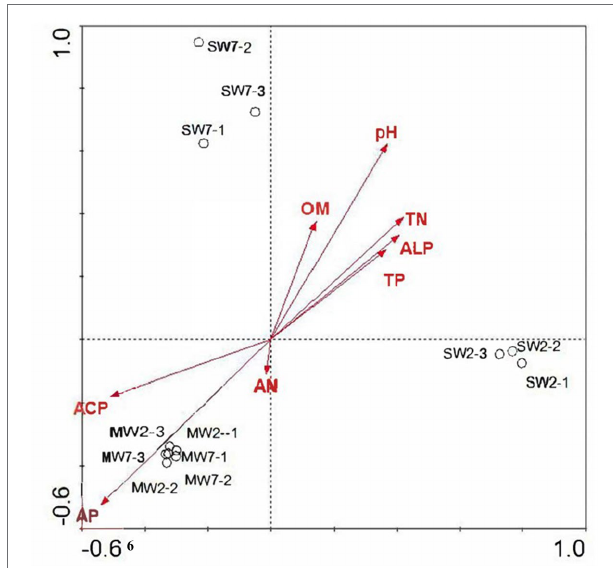
FIGURE 9 | Redundancy analysis of soil microbial functional genes involved in P transformation among treatments according to soil